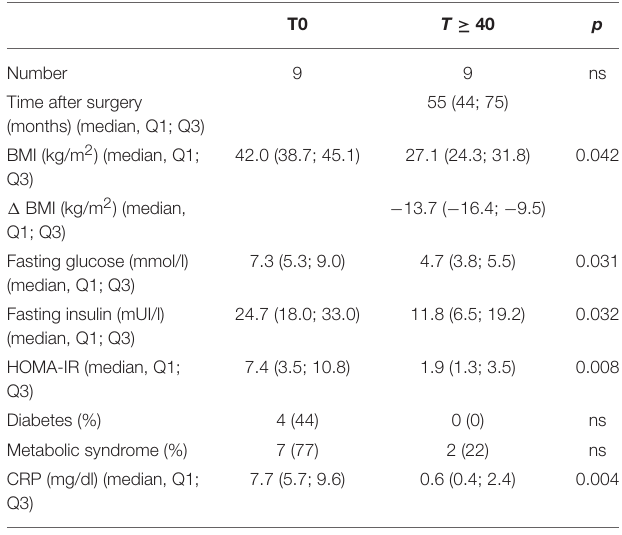
TABLE 1 | Patients’ clinical and biochemical parameters at baseline and after a ≥ 40-month follow-up period (patients with paired liver biopsies).